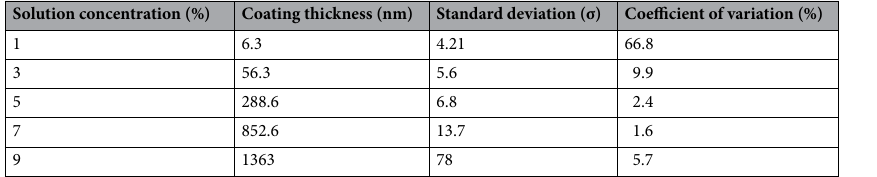
Table 1. Variation of solution concentration and coating